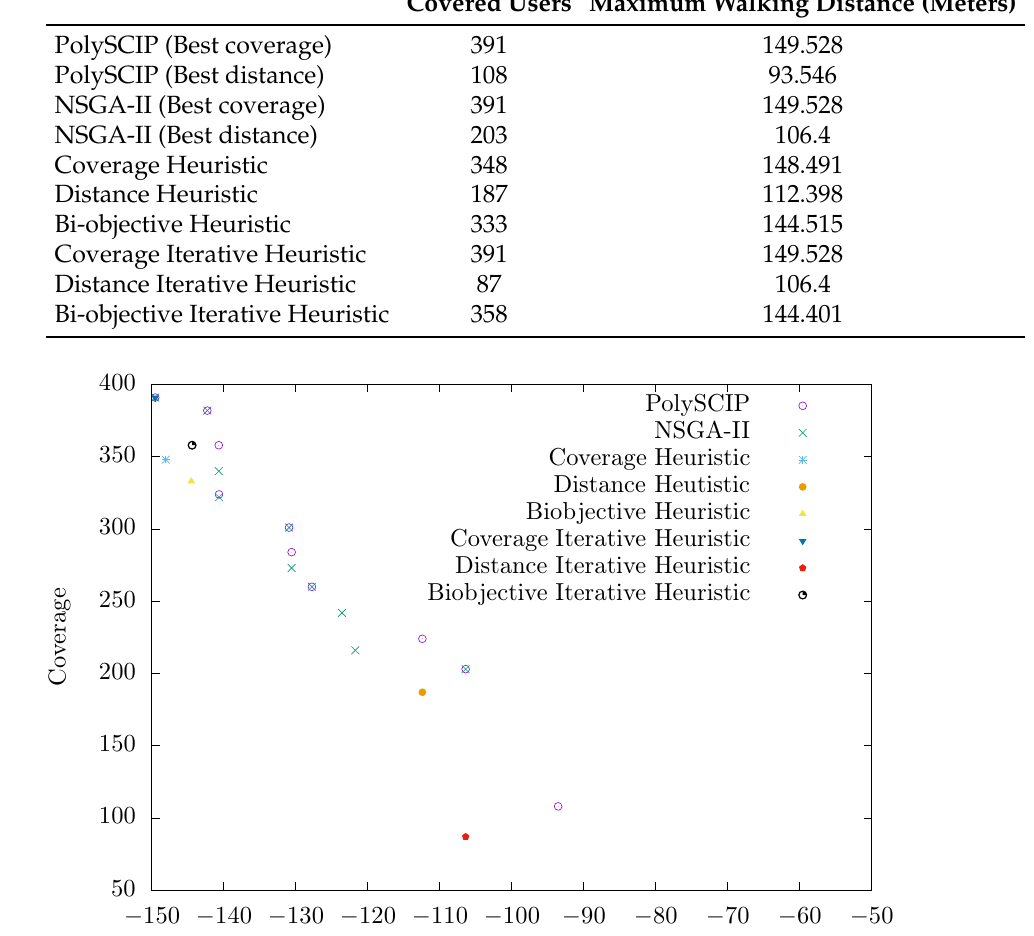
Figure 7. Results in the validation phase. The higher the value on the x axis (moving toward the right), the better the distance objective is. The higher the value on y axis, the better the user coverage objective